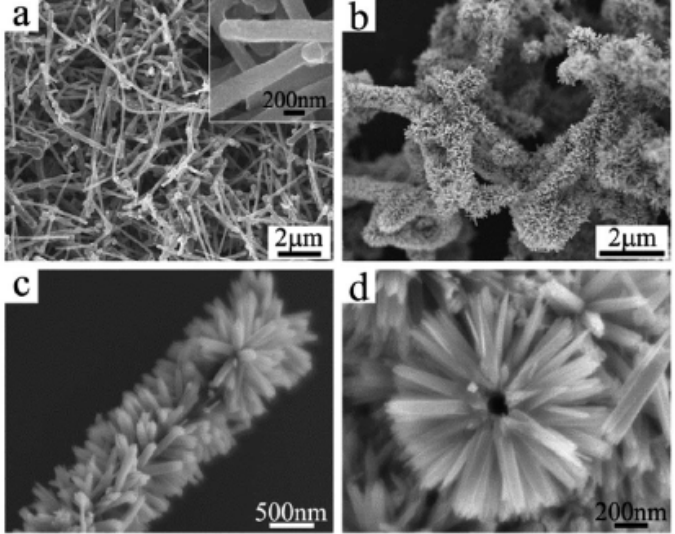
Figure 4. SEM images of b-CNTs ( a ) and b-CNT@SnO 2 heterostructures ( b – d ). Used with permission of The Royal Society of Chemistry, from [44], Copyright© 2013; permission conveyed through Copyright Clearance Center, Inc.